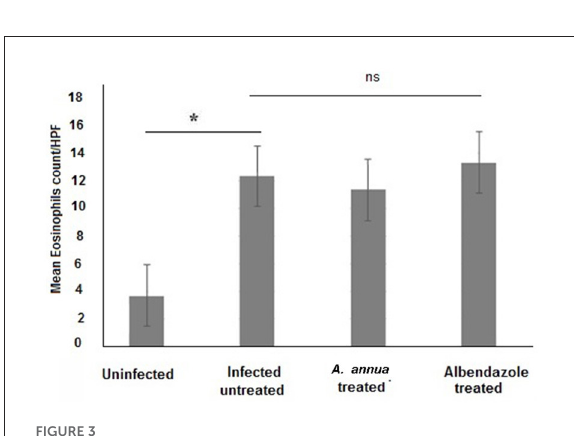
FIGURE3 Eosinophil cell numbers in intestinal tissues of different groups of mice. Infection of mice with T. spiralis significantly increased eosinophil cell number in intestinal tissue/high power field (HPF) compared to uninfected mice. Treatment with either A. annua or albendazole (positive control) did not result in significant change (ns) in eosinophil cell numbers infiltrating the mucosa and submucosa of small intestine compared to infected untreated mice. Asterisk (*) indicate significant difference between uninfected and infected untreated mice ( p < 0.007), whereas ns, non-significant.